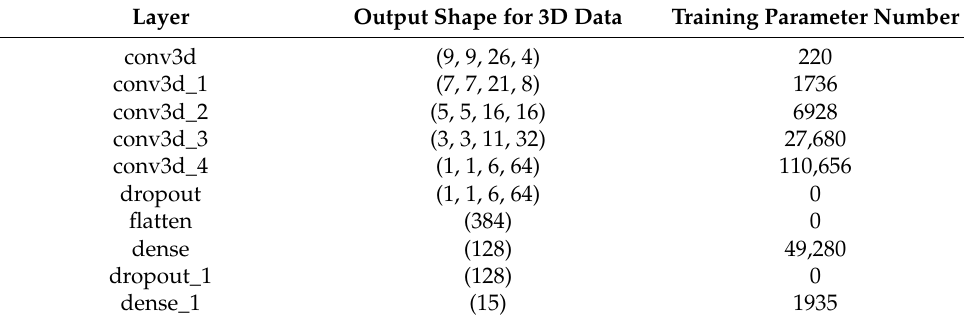
Table 4. 3D-CNN model structure.